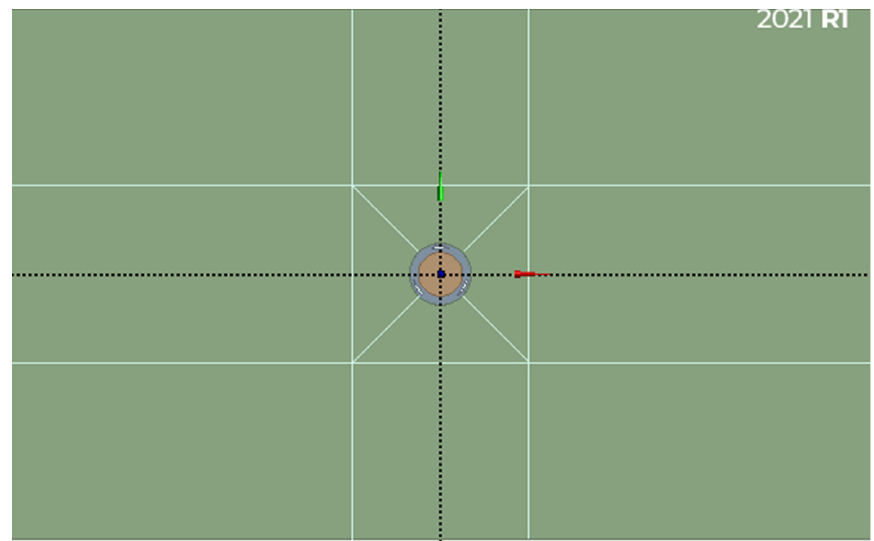
Figure 2. DesignModeler geometry.